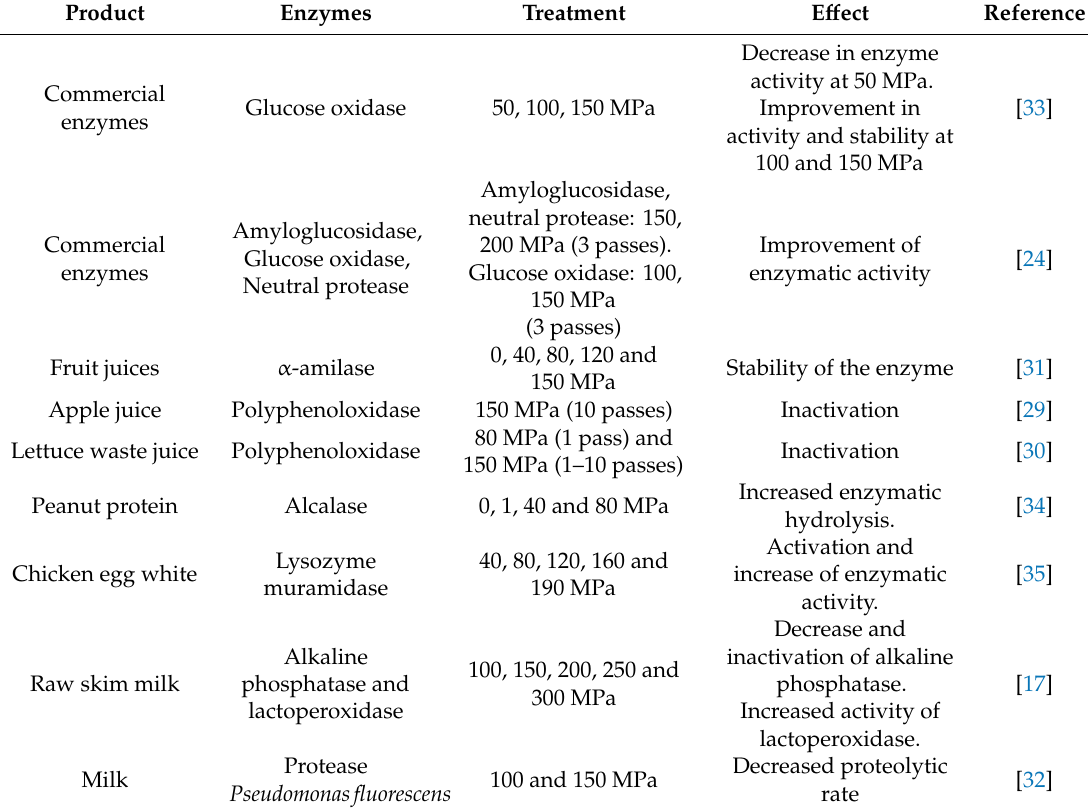
Table 2. Research works evaluating enzyme activity modulation by